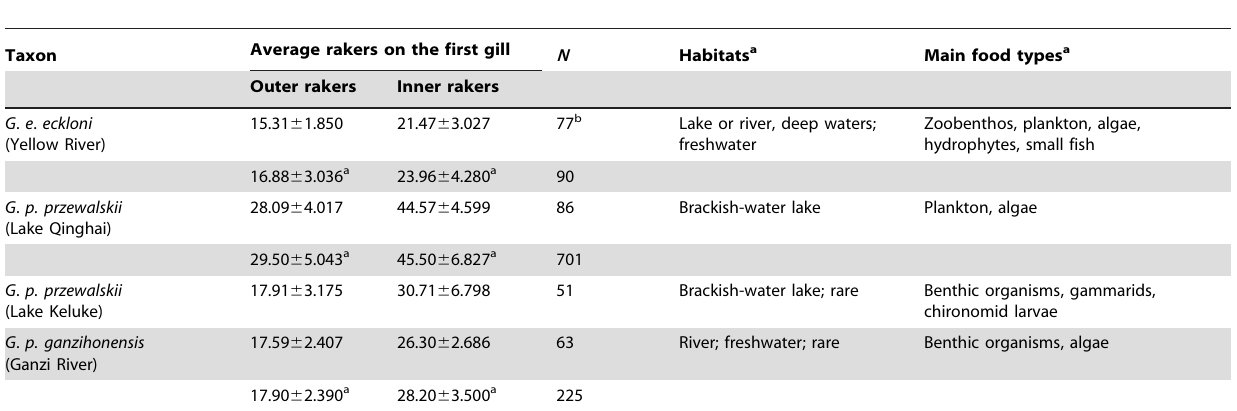
Table 3. Morphological and ecological characteristics of the Gymnocypris morphs in this